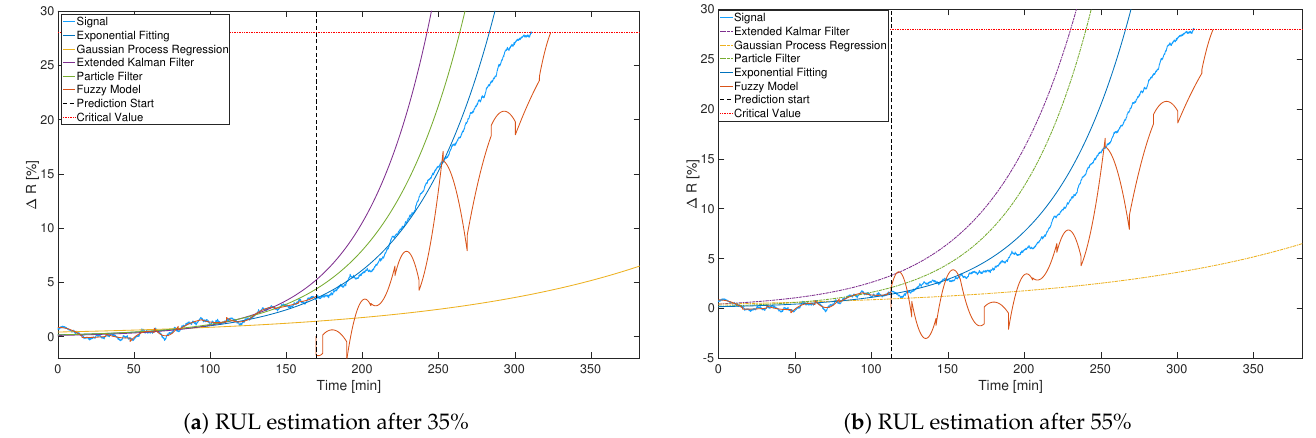
Figure 19. Comparison of RUL predictions by different